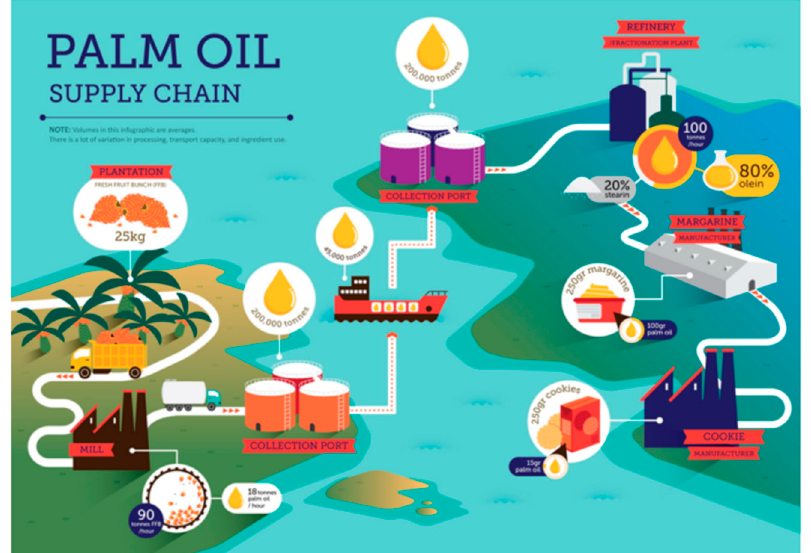
Figure 4. Supply and Distribution, Roundtable on Sustainable Palm Oil (2020). Third-party certifi- cation schemes, such as RSPO certification and ISEAL global member programs, are a step in the right direction in improving the sustainable management of palm oil. These schemes ensure inter- connectedness of stakeholders and legitimize local supply chain relations in sourcing, milling, and refining palm oil derivatives. Roundtable on Sustainable Palm Oil, 2020.